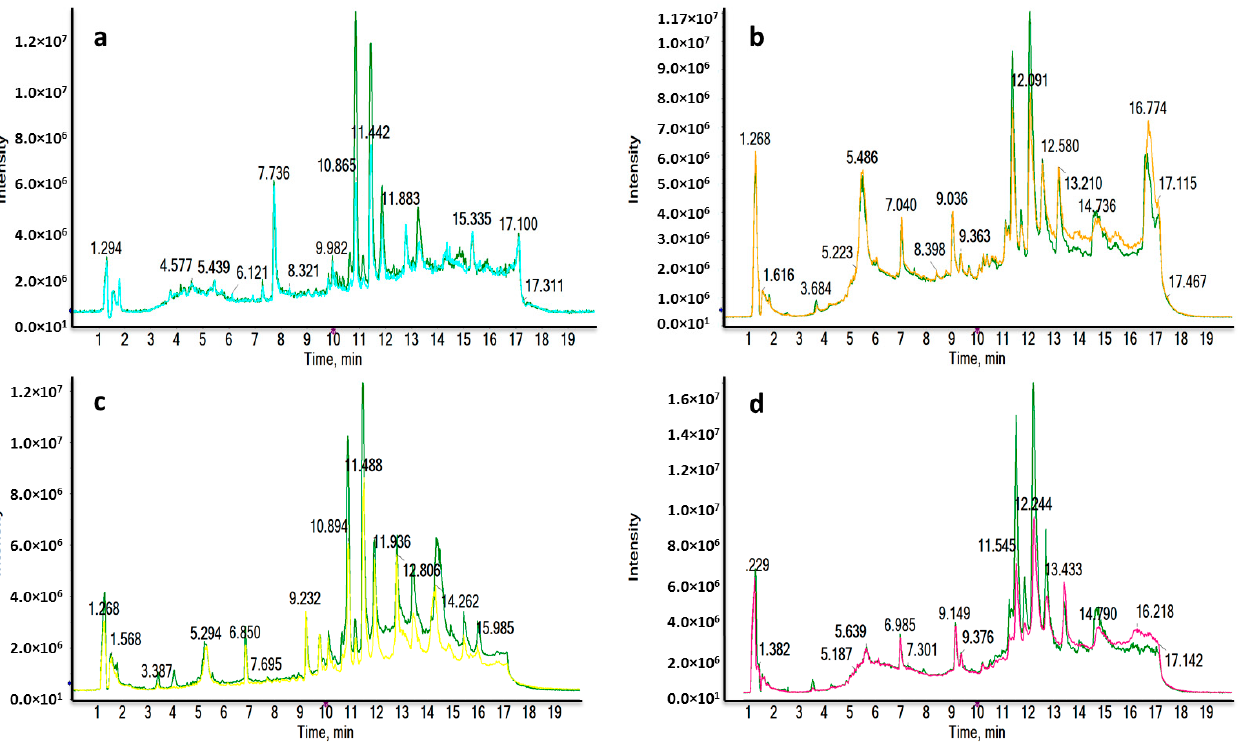
Figure 1. Representative RPLC-ESI+-HRMS TICs of a LA_BC (light blue) ( a ), HER2_BC (orange) ( b ), TN_BC (yellow) ( c ) and LB_BC (pink) ( d ) sample compared to a HC sample (green). Remarkable differences were observed between BC and HC samples.